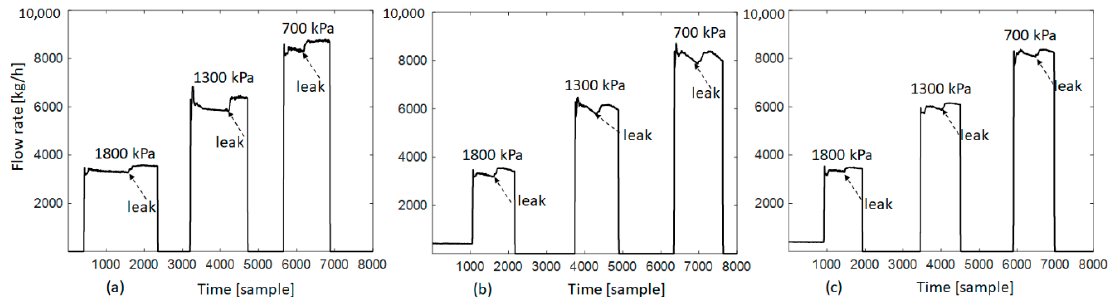
Figure 3. Gas flow rates corresponding to three orifices: ( a ) 0.3 mm, ( b ) 0.5 mm, ( c ) 1.0 mm.